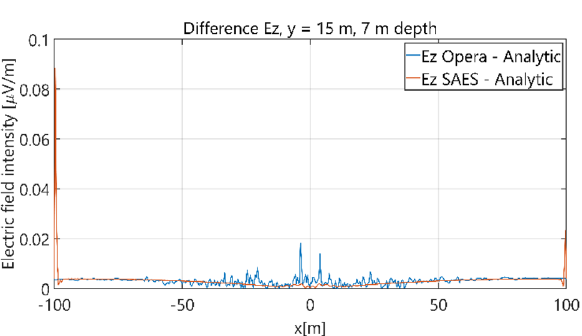
Figure 19. Distribution of differences between E z values obtained from Opera (FEM) and SAES (BEM) models and the analytical model ( y = 15 m, z = − 7 m, case